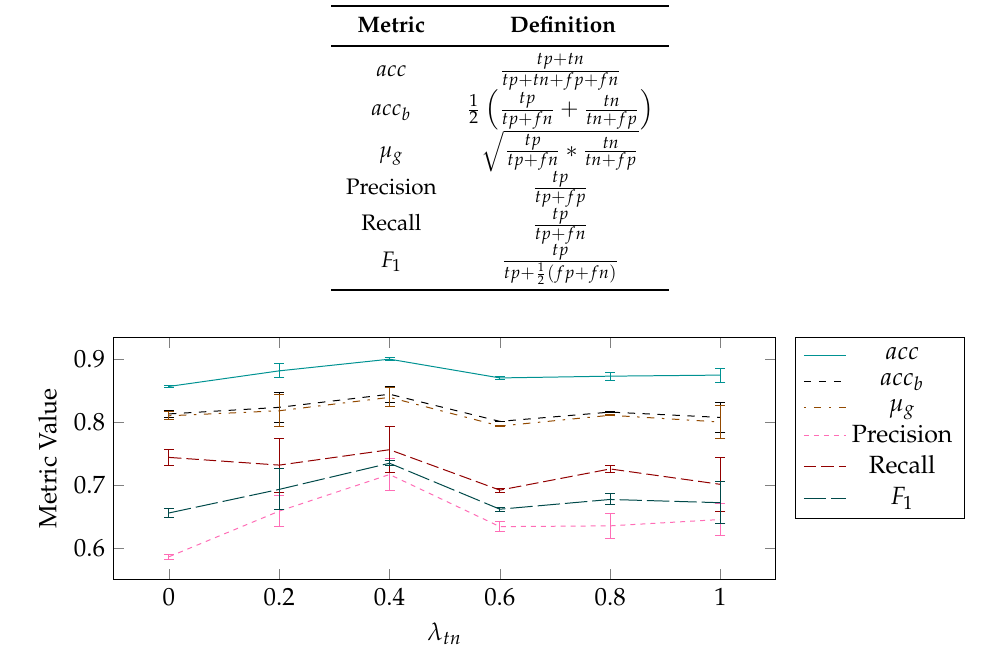
Table 3. Definitions of all metrics used in this work. tp , f p , tn , and fn are short for true positive, false positive, true negative, and false negative, respectively, defining the possible kinds of predictions in a classification task.